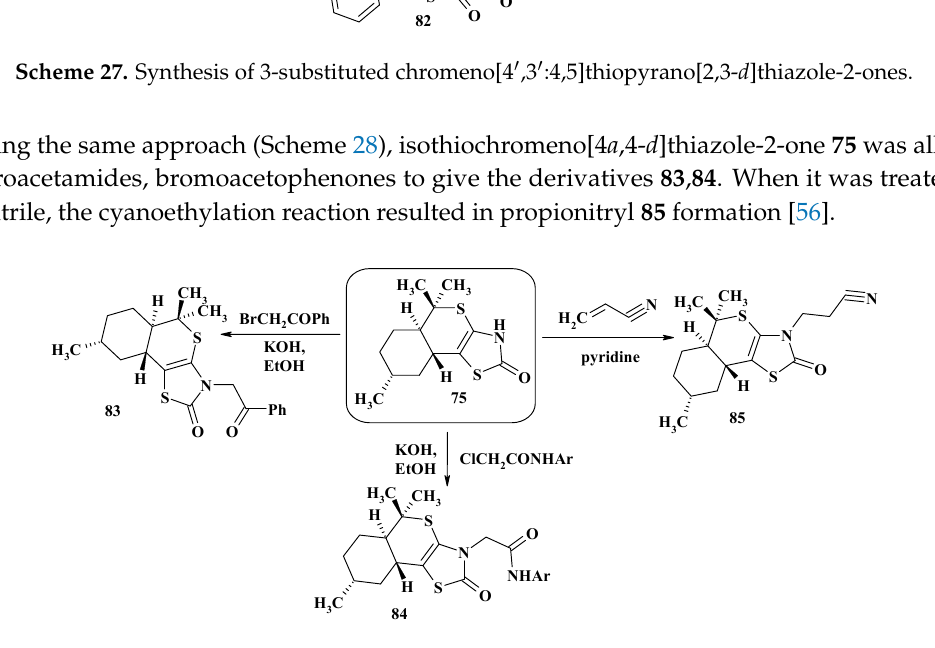
interaction of isorhodanine with structural analogs of